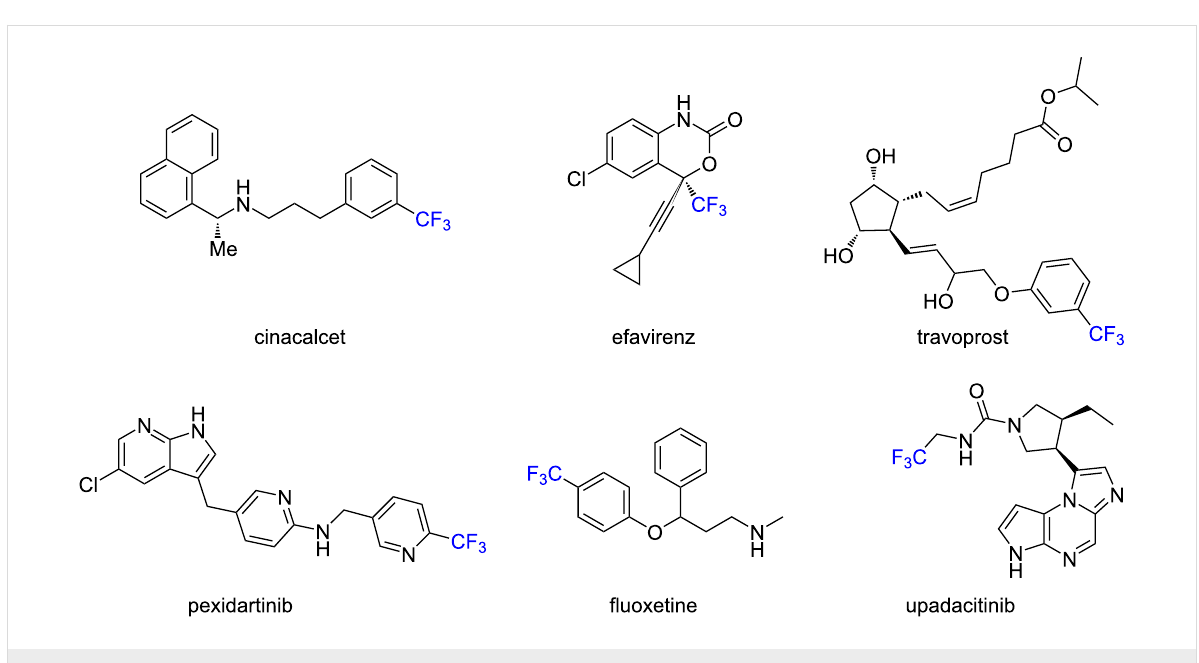
Figure 2: Selected examples of CF 3 -containing biologically active